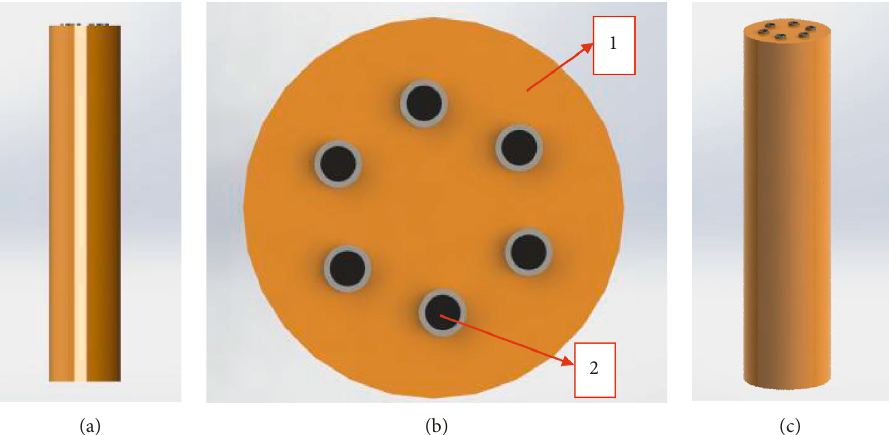
Figure 19: Outside view of the bamboo-reinforced cemented soil column (1: column body; 2: bamboo): (a) front view; (b) plan view; (c) spatial